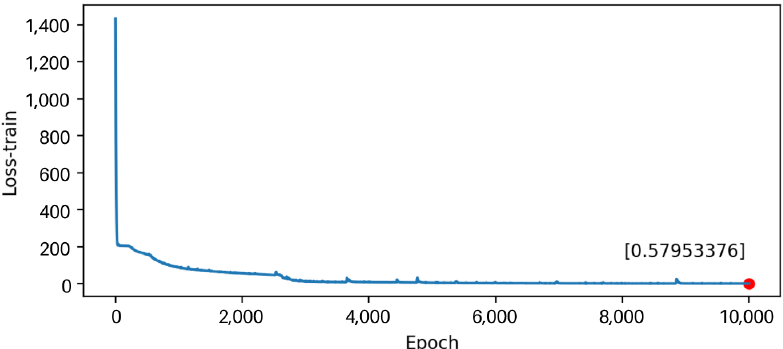
Figure 18. The training and prediction after optimizing model parameters.